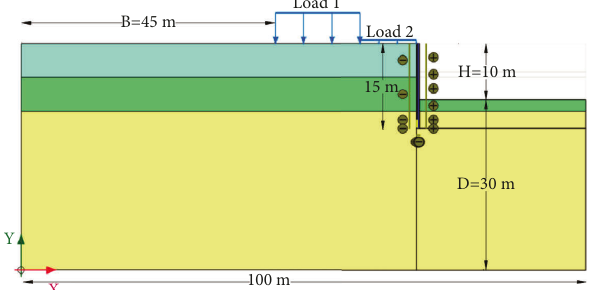
Figure 10: PLAXIS 2D V20 model.